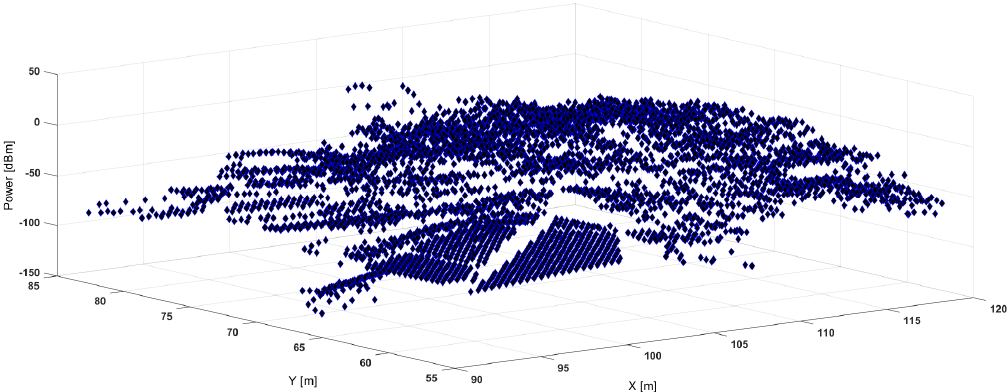
Figure 2. Distribution of power levels in the radio map. It represents the visibility of each fingerprint with respect to each AP available in the scenario, and it is the information used in the cost function based on